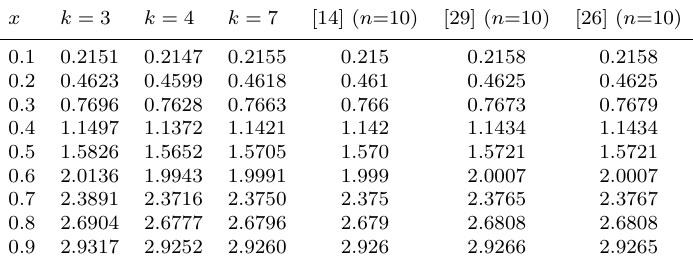
Table 6. Numerical results of Example 6. x k = 3 k = 4 k = 7 [14] ( n =10) [29] ( n =10) [26] ( n =10) 0.1 0 . 2151 0 . 2147 0 .